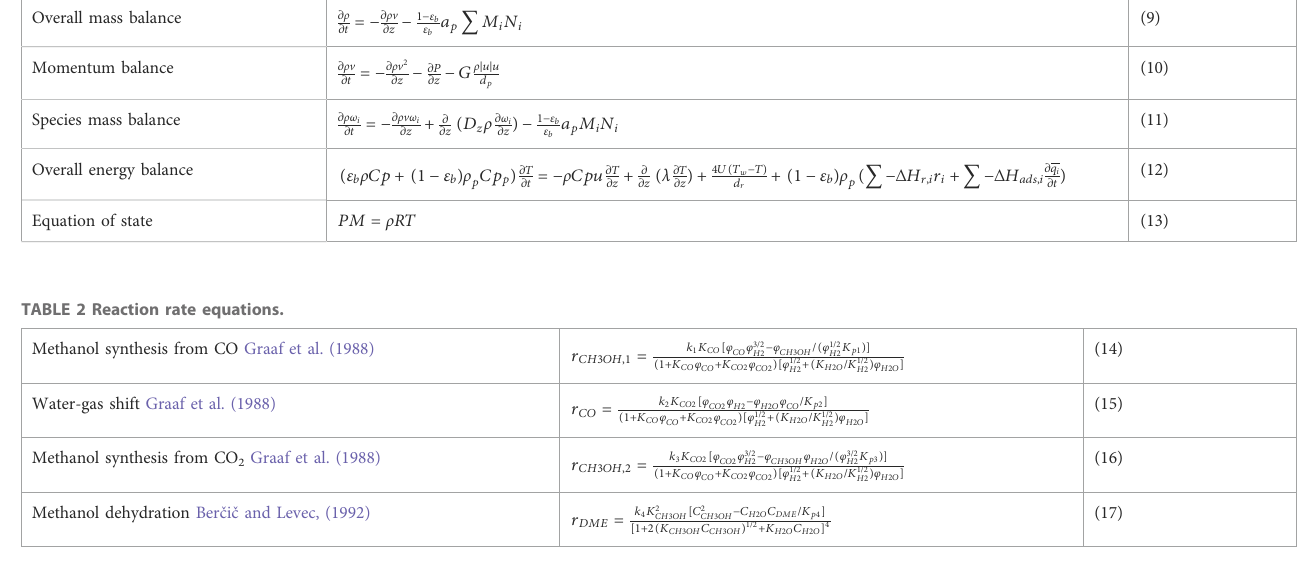
TABLE 3 Reaction rate parameters for methanol synthesis and dehydration reaction kinetics (van Kampen et al., 2021c).